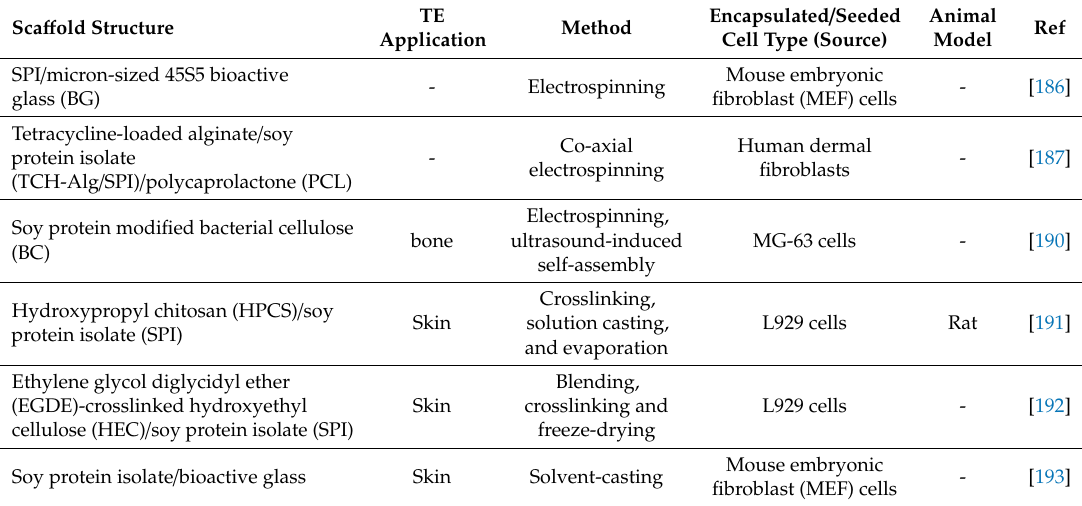
Table 6. Studies using soy protein-based matrices / sca ff olds for tissue engineering (TE)